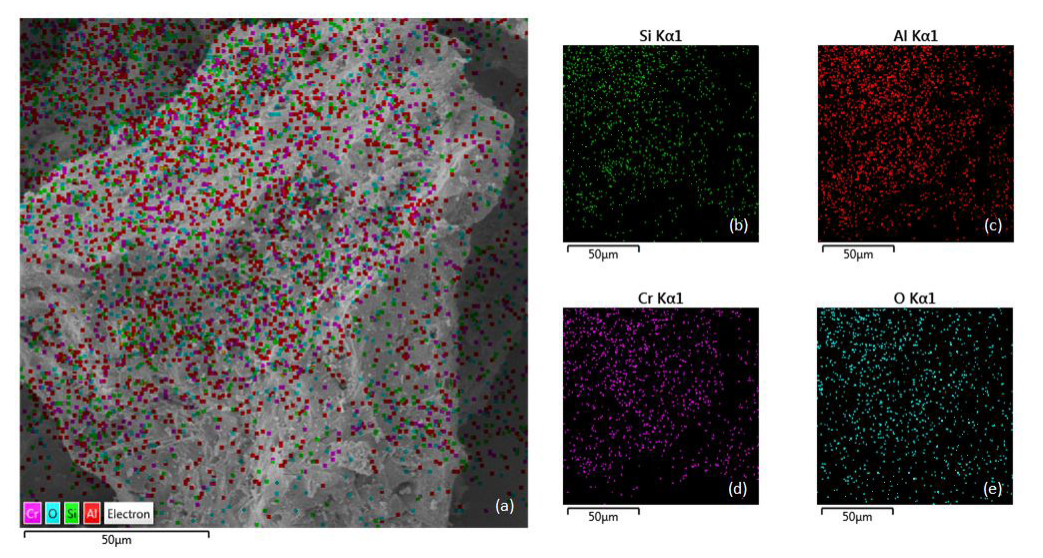
Figure 3. SEM image and overlaid EDS of β-LiAlSi